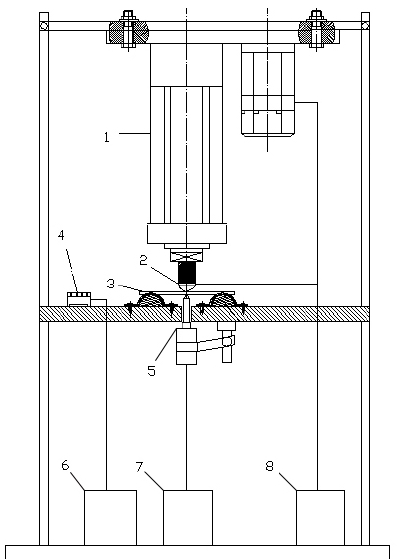
Figure 3. Schematic diagram of creep testing device: 1—electric cylinder; 2—pressure Sensor; 3—specimen; 4—temperature and humidity sensor; 5—linear displacement sensor; 6—temperature and humidity controller; 7—acquisition card; 8—control system.